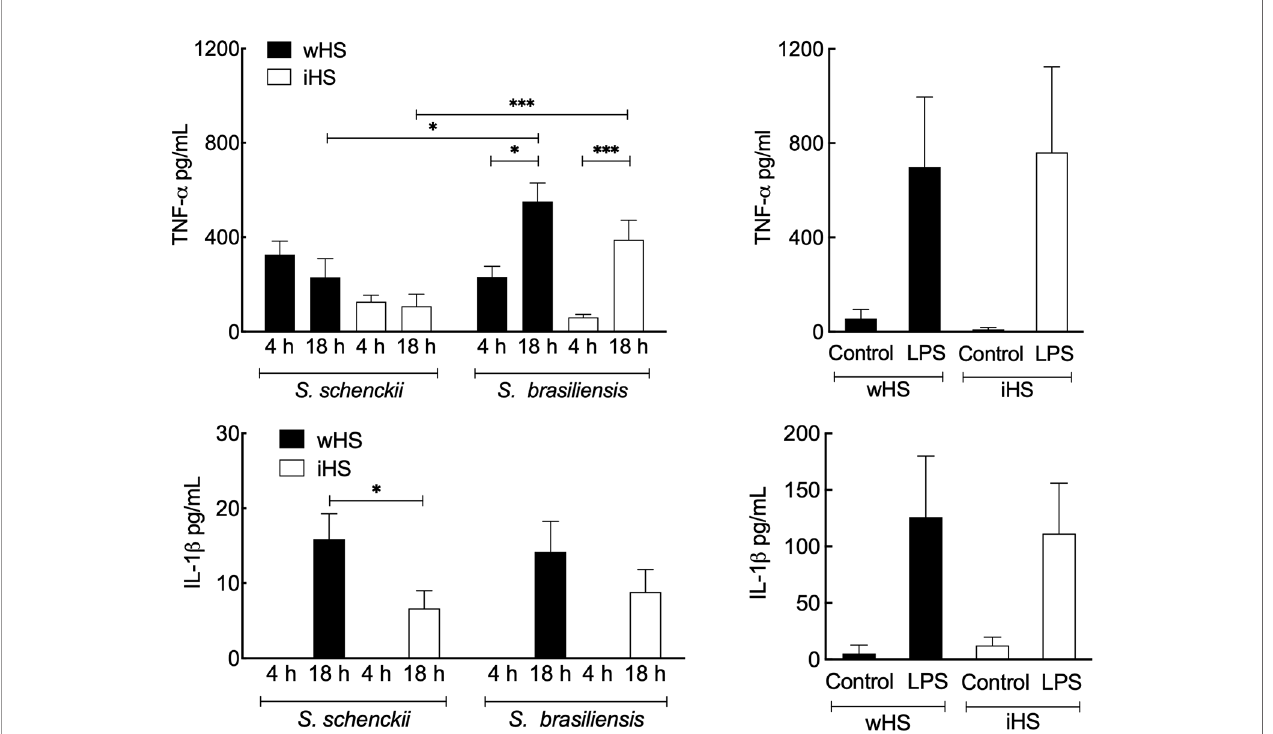
FIGURE 4 | Cytokine release by human monocyte-derived macrophages (hMDMs) following interaction with Sporothrix species. Sporothrix schenckii and Sporothrix brasiliensis yeasts were made to interact with hMDMs in culture medium supplemented with human serum [whole (wHS) or inactivated (iHS)] for 4 – 18 h at 37°C and 5% CO 2 . The culture supernatants were collected and analyzed for tumor necrosis factor (TNF)- a and interleukin (IL)-1 b [positive control was the lipopolysaccharide (LPS)-stimulated hMDM]. Results are the mean ± SEM of at least two independent experiments ran in duplicate (n = 4 or 6). Statistical analysis was performed by ANOVA with Tukey ’ s multiple comparison posttest (***p < 0.005 and *p <